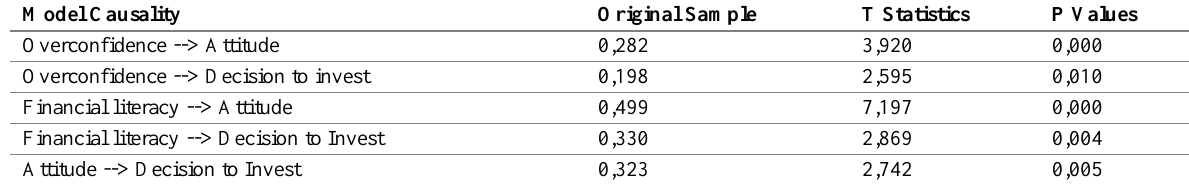
Table 4: Model Causality Test